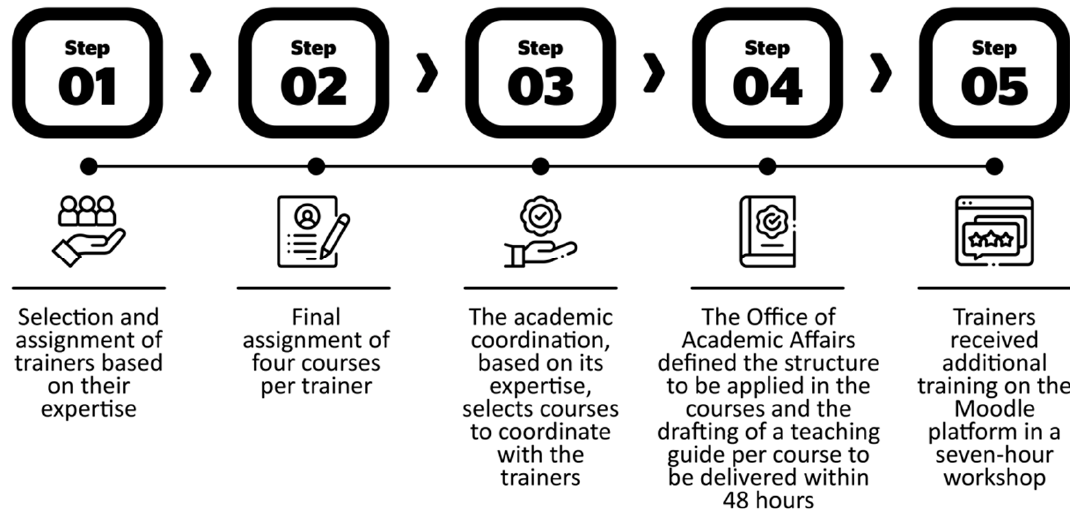
Figure 4. Trainer distribution in the courses.